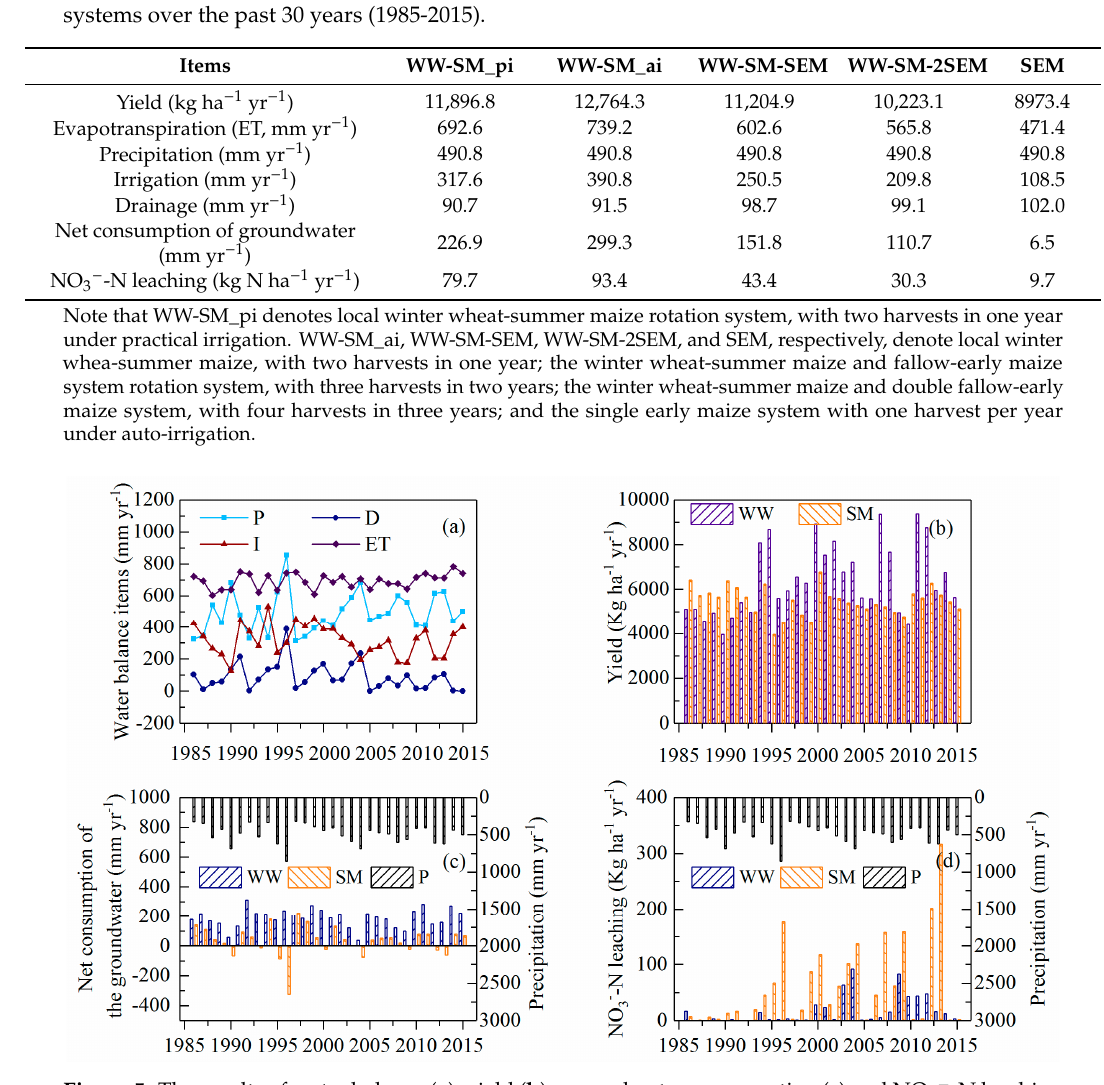
Figure 5. The results of water balance ( a ), yield ( b ), groundwater consumption ( c ) and NO 3 − -N leaching ( d ) of local rotation system of winter wheat and summer maize under practical irrigation (WW-SM_pi) over the past 30 years (1985–2015). P, I, D, ET, WW, and SM, respectively, denote precipitation, irrigation, drainage, evapotranspiration, winter wheat, and summer